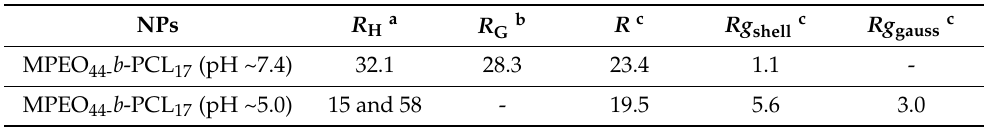
Table 2. Structural features of the prepared MPEO 44 - b -PCL 17 block copolymer nanoparticles before (pH ~ 7.4) and after (pH ~ 5.0) degradation.